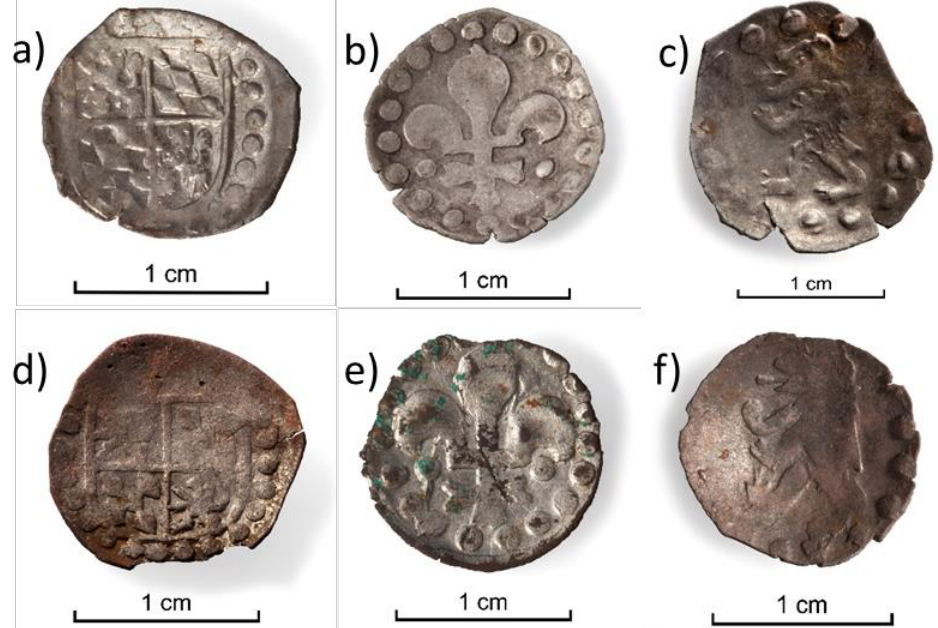
Figure 1. Examples of counterfeit coins from the hoard of Preuschdorf ( d – f ) compared to their official counterparts ( a – c ). Details of their provenance are given in Table 1. (Photos: Anaïs Vigneron, Archéologie-Alsace).